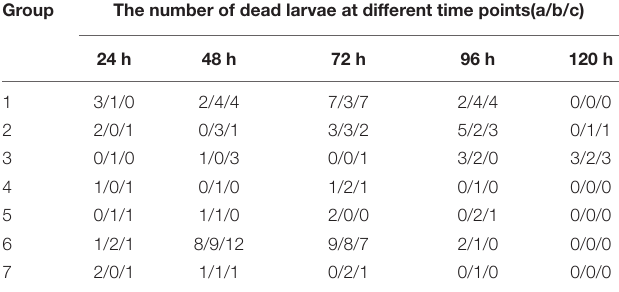
TABLE 1 | Viral neutralization assay. Group